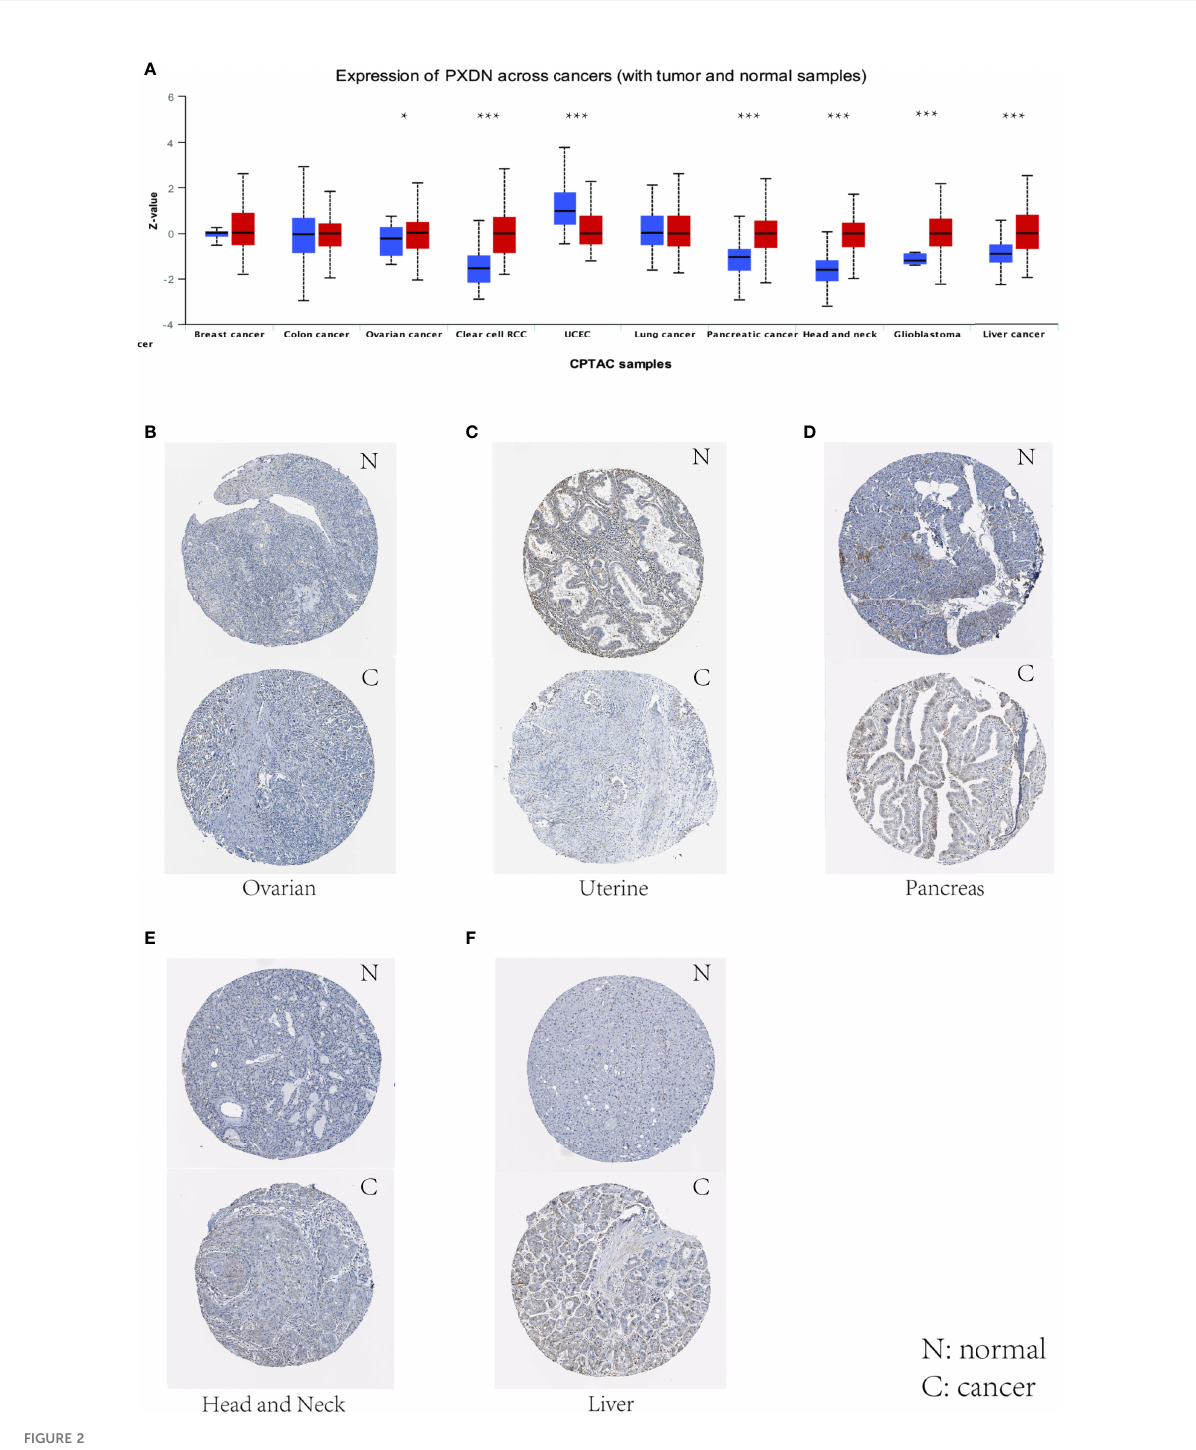
FIGURE 2 Levels of PXDN in different tumours. Results based on CTPAC and HPA database. (A) PXDN is differentially expressed in breast cancer, ovarian cancer, colon cancer, clear cell renal cell carcinoma (RCC), UCEC, lung cancer, pancreatic cancer, head and neck carcinoma, glioblastoma and liver cancer in tumour tissues and normal tissues in CTPAC database. (B – F) The IHC of PXDN in ovarian cancer, pancreatic cancer, head and neck carcinoma and liver cancer was much higher than that in normal tissues. *p < 0.05, ***p <